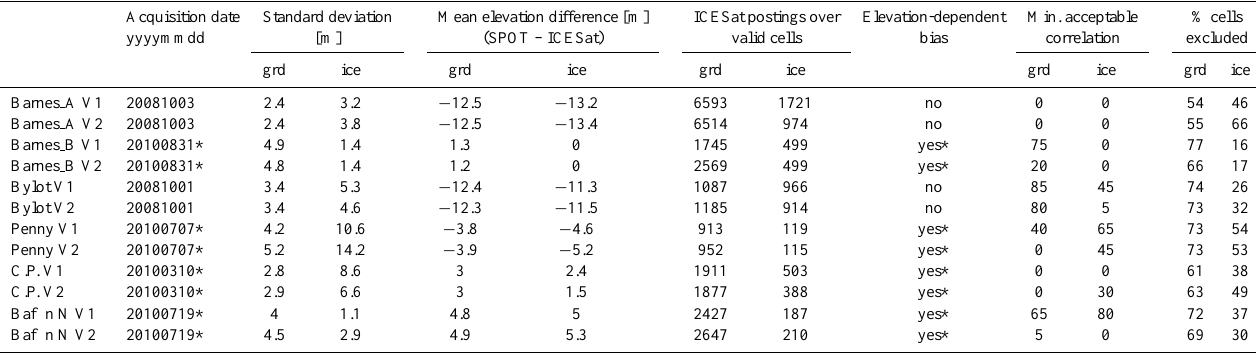
Table A1. ICESat validation and filtering of SPOT DEMs over glacier-free ground (grd) and over glacier ice (ice). C.P. stands for Cumberland Peninsula.